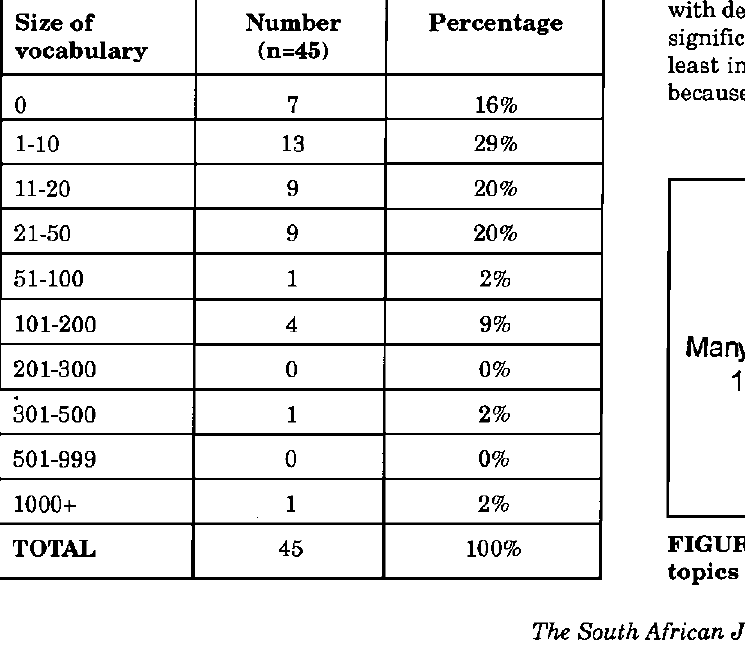
TABLE 2: Mothers' estimation of their signing vo- cabulary